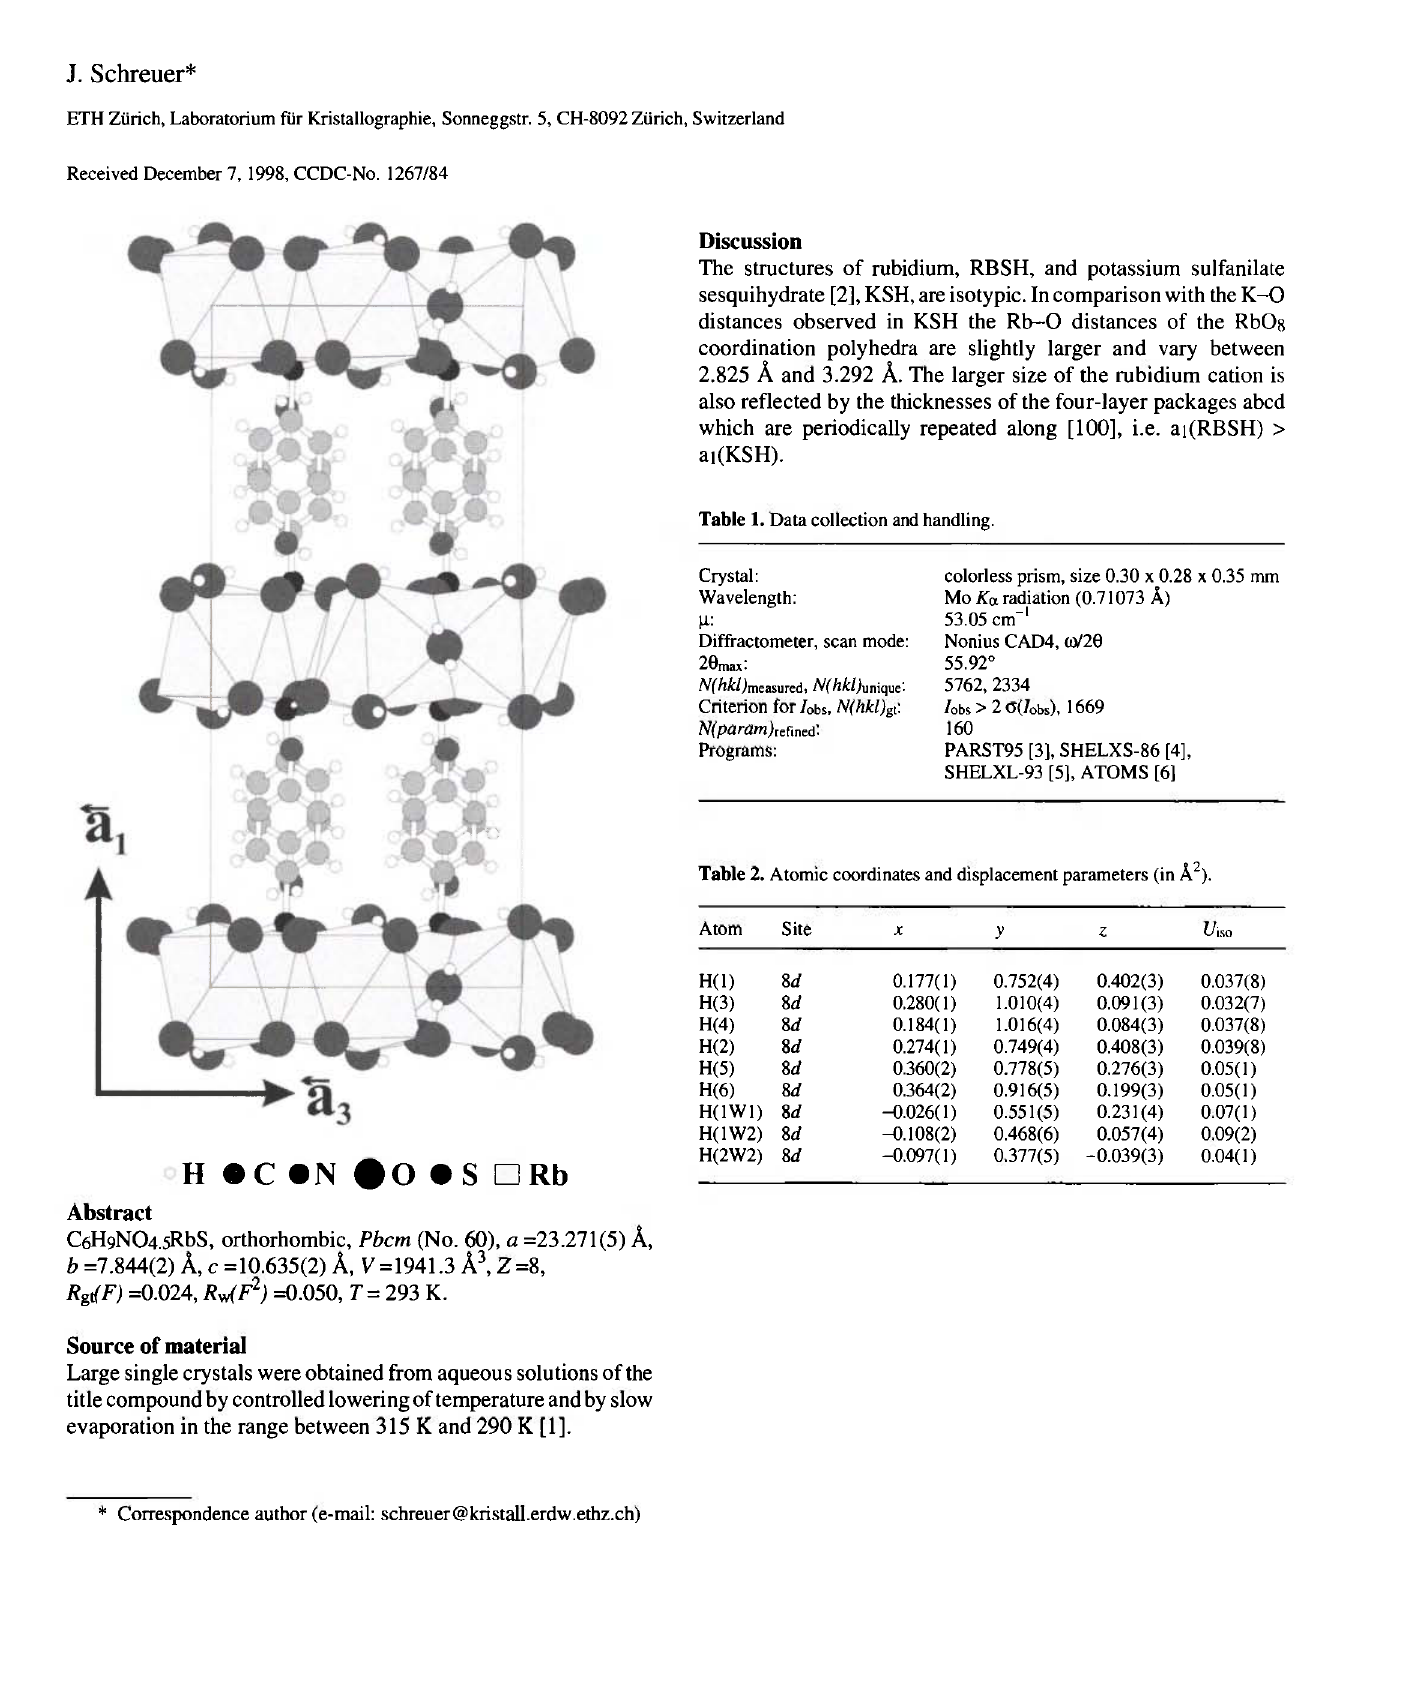
Table 2. Atomic coordinates and displacement parameters (in Ä 2